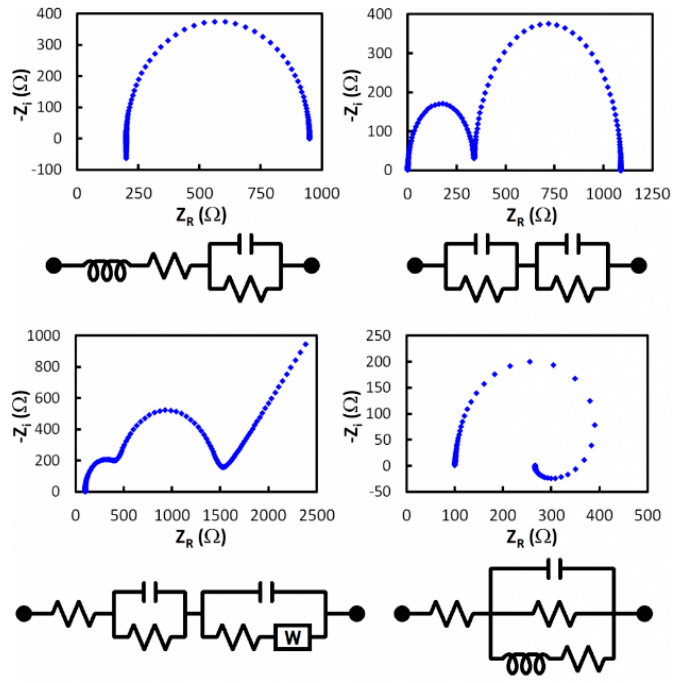
Figure 5. Experimental and simulated impedance spectra (examples of Nyquist plot curves and their equivalent circuits).